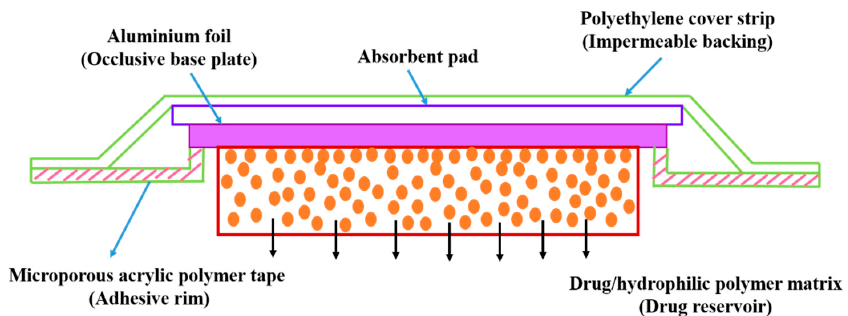
Figure 17 . Nitro-Dur system (adapted from [140]).